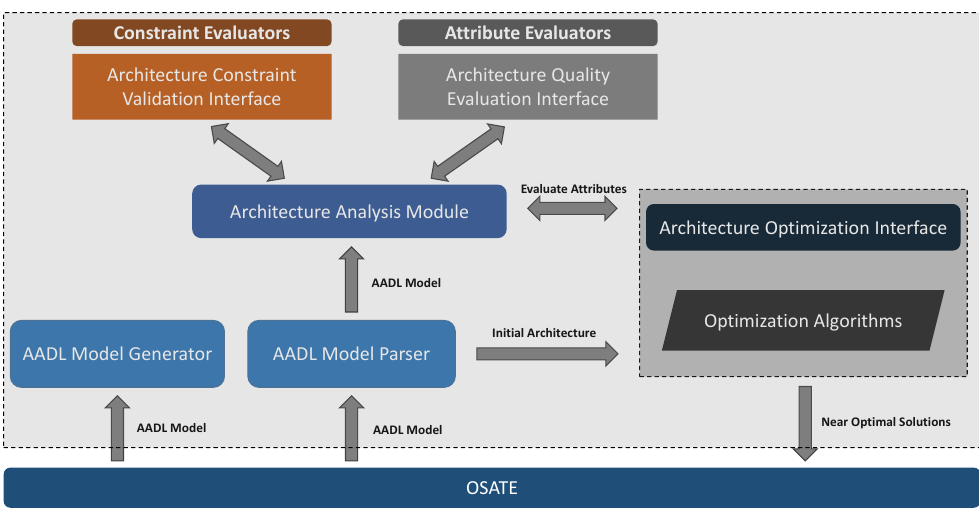
Figure 5. The architecture of ArcheOpterix